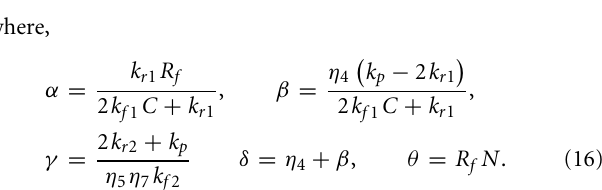
FIGURE 2 | (A) Typical profile of unboundVEGF, the source of which is located at x = 1. (B) Various choices for the chemotactic sensitivity of an endothelial cell toVEGF bound to its surface receptors, as a function of the fraction of activatedVEGFR2 per cell face. (C–F) Average migration times (in hours) for a single cell to travel across a 1mm × 1mm domain as a function of increasing the maximum freeVEGF concentration at a lattice site, for various choices of the chemotactic sensitivity function. Cells are